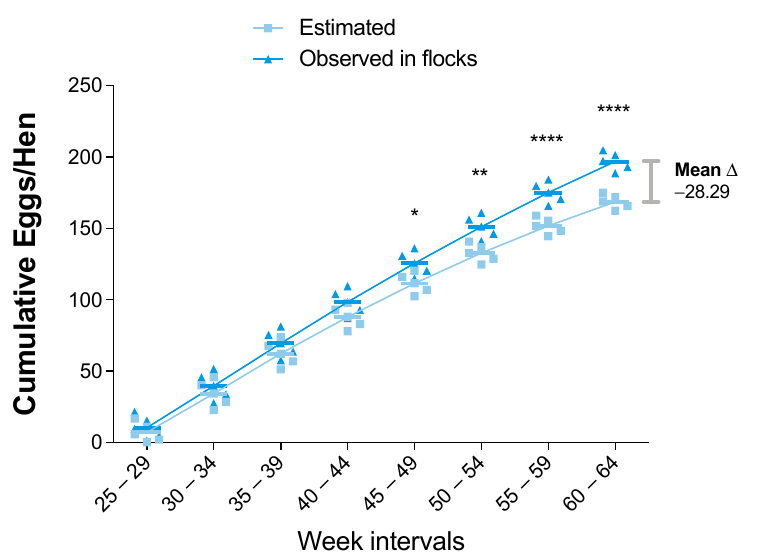
Figure 3. Cumulative egg/hen production (CEHP) for estimated and observed flocks. Results are presented as mean and standard deviation, and mean differences (shown as delta “ ∆ ” mean) were calculated subtracting observed from estimated values. Comparisons were performed using the two-way ANOVA test followed by the Bonferroni correction post-hoc test. * p < 0.05; ** p < 0.005; *** p < 0.0005; **** p <